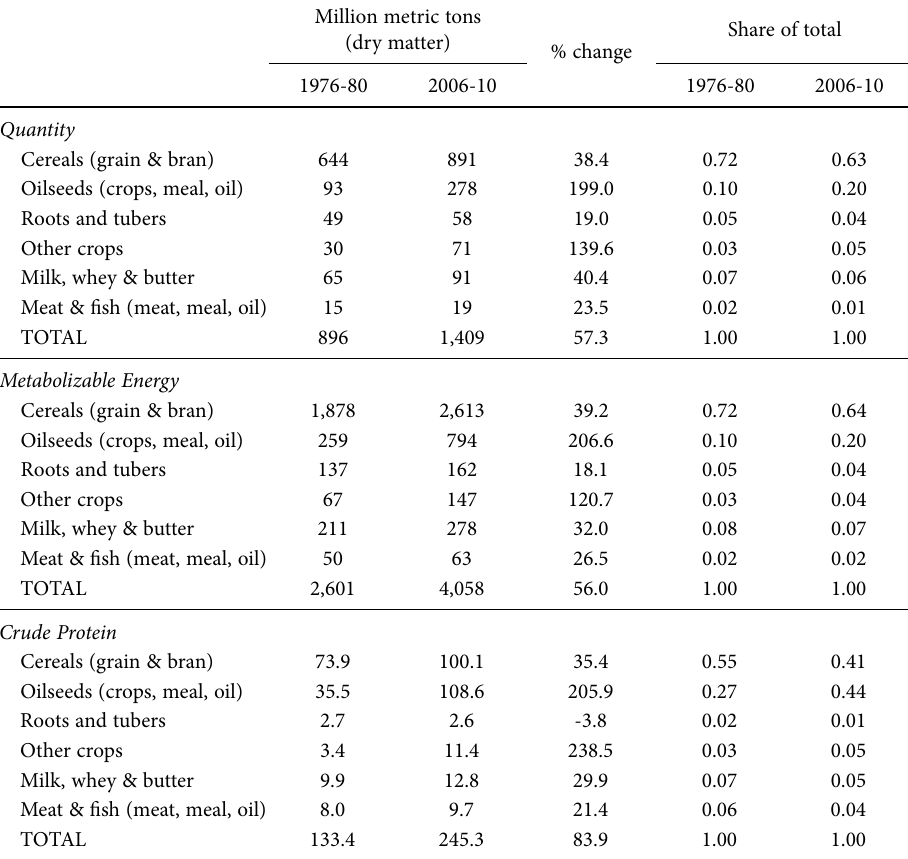
Table 1. The Changing Composition of Global Animal Feed (average annual